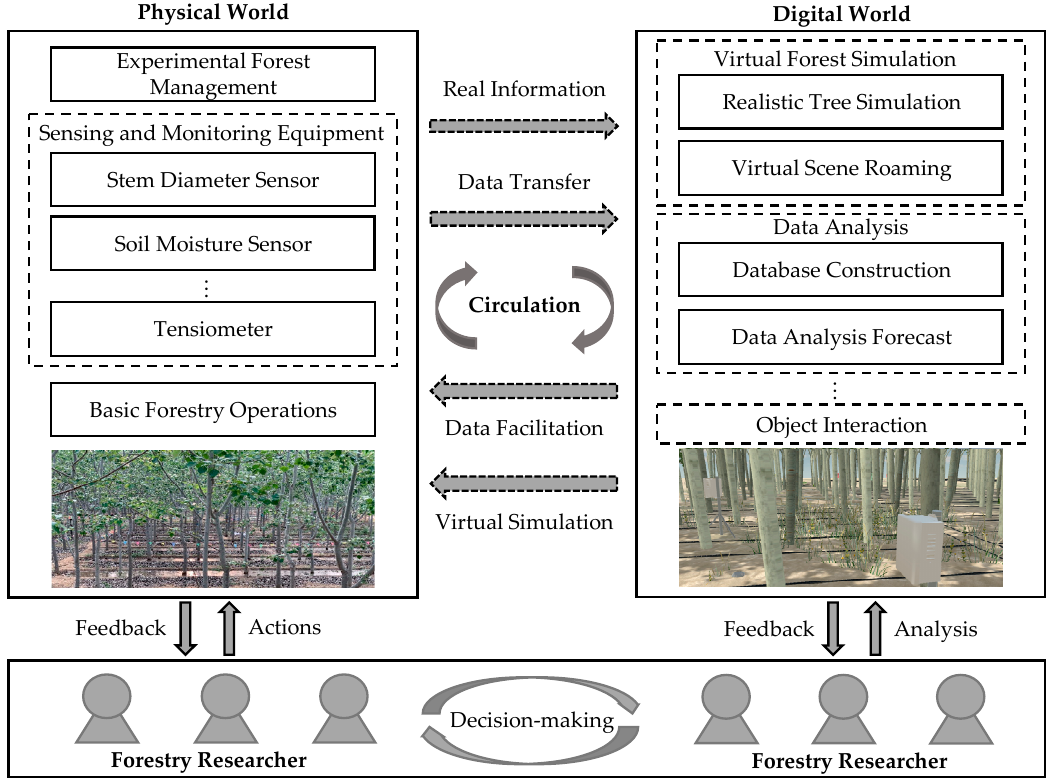
Figure 1. Architecture of virtual poplar plantation system based on digital twin.